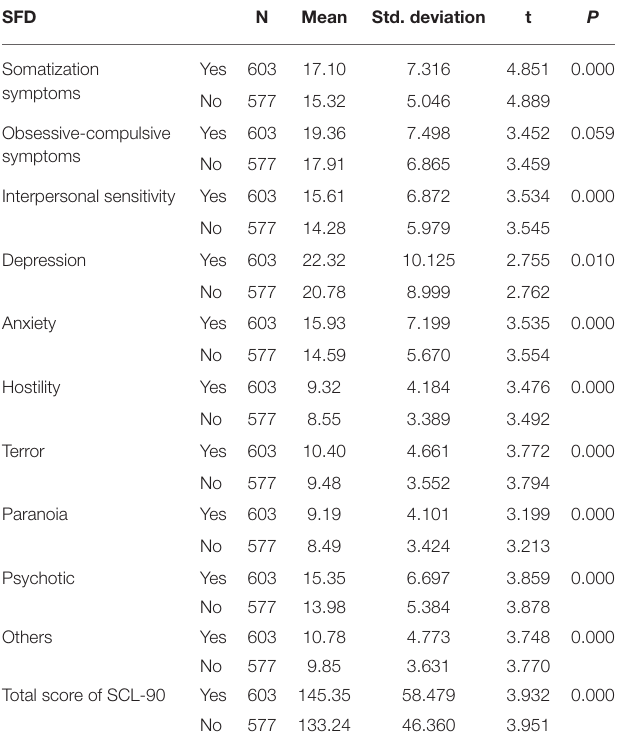
TABLE 4 | The SCL-90 scores of SFD and non-SFD.